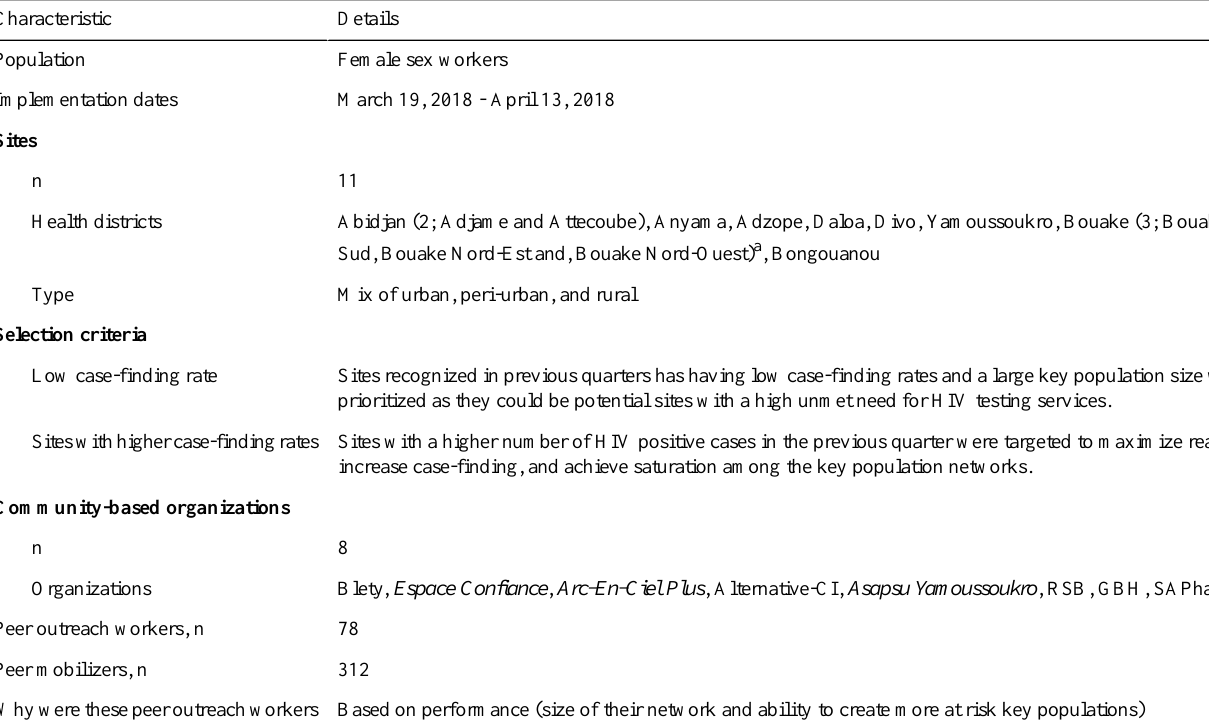
Table 1. Implementation details of the enhanced peer outreach approach in Côte d’Ivoire.